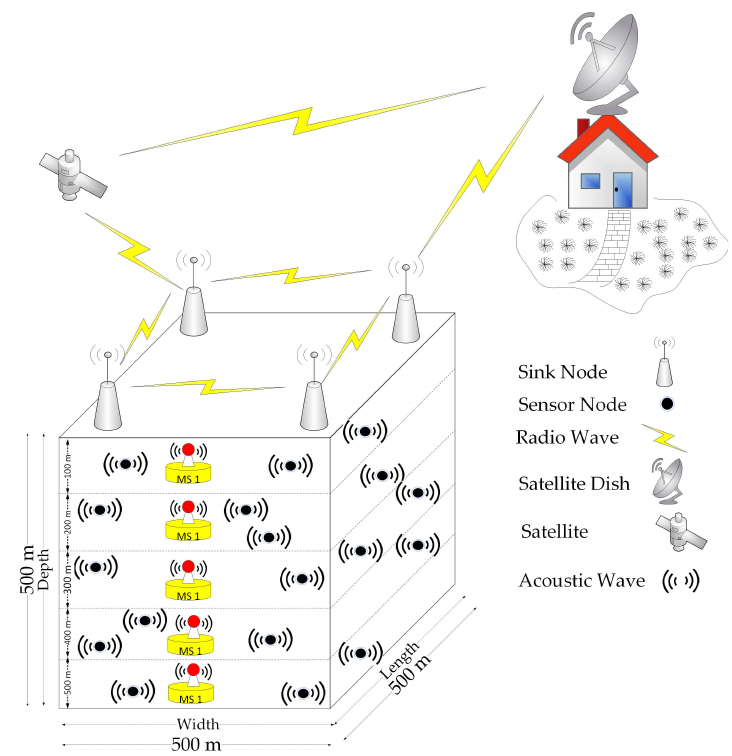
Figure 7. The cooperative depth and noise-aware routing (Co-DNAR) network architecture.